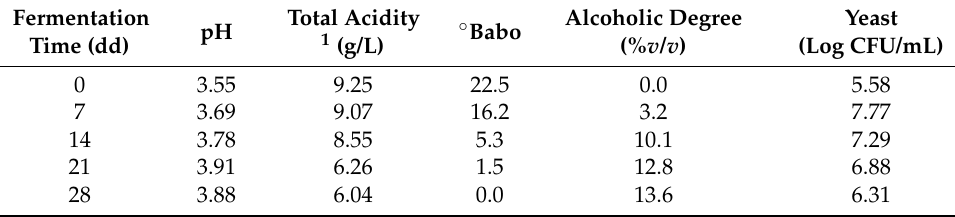
Table 1. Yeast loads and main oenochemical parameters detected during